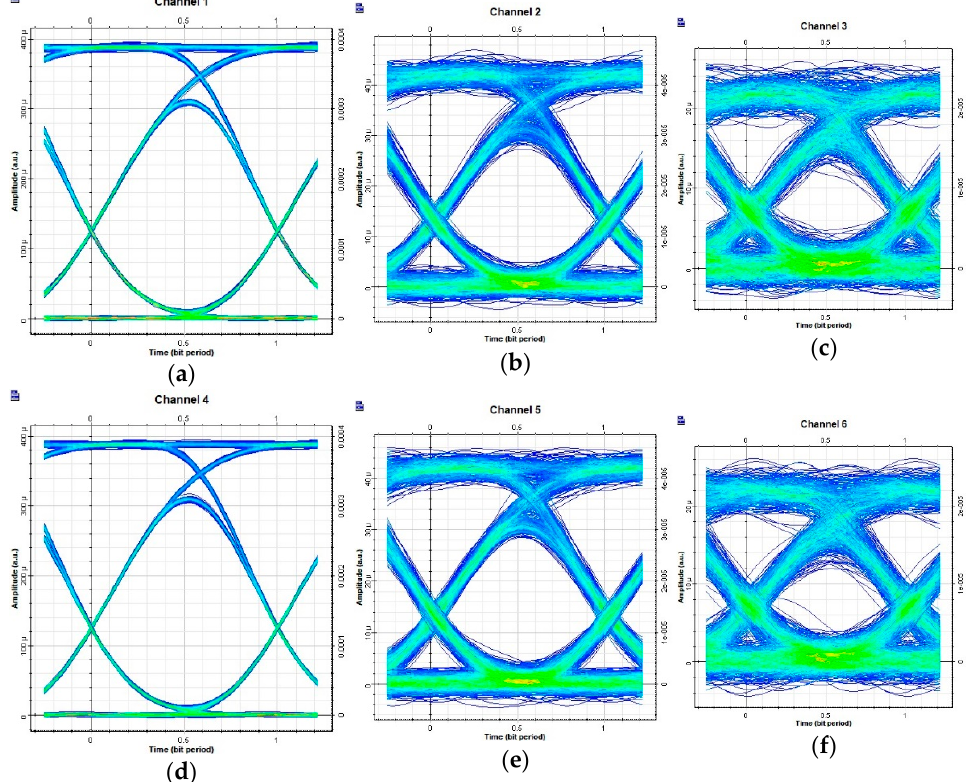
Figure 9. Eye diagrams for ( a ) channel #1, ( b ) channel #2, ( c ) channel #3, ( d ) channel #4, ( e ) channel #5, and ( f ) channel #6 under HD at 40 m FSO range.